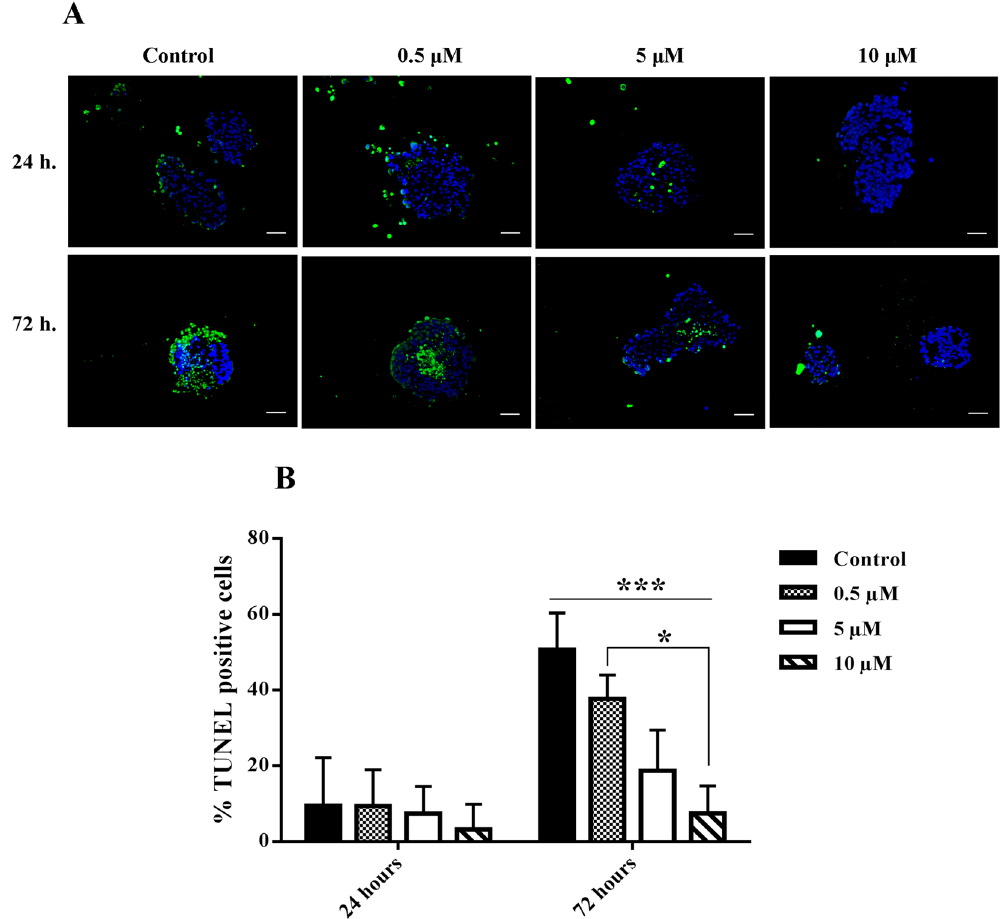
Figure 2. Islet apoptosis evaluation with TUNEL assay in different concentrations of nobiletin. ( A ) The TUNEL positive cells are visible as green stained nuclei. Scale bar = 100 μ m. ( B ) The percentage of TUNEL positive cells was also calculated and shown as graphs. The experiment was done in triplicate from four donors and data were analyzed by Kruskal-Wallis and Post-hoc tests. Results were represented as mean ± SD. * p < 0.05, and *** p <